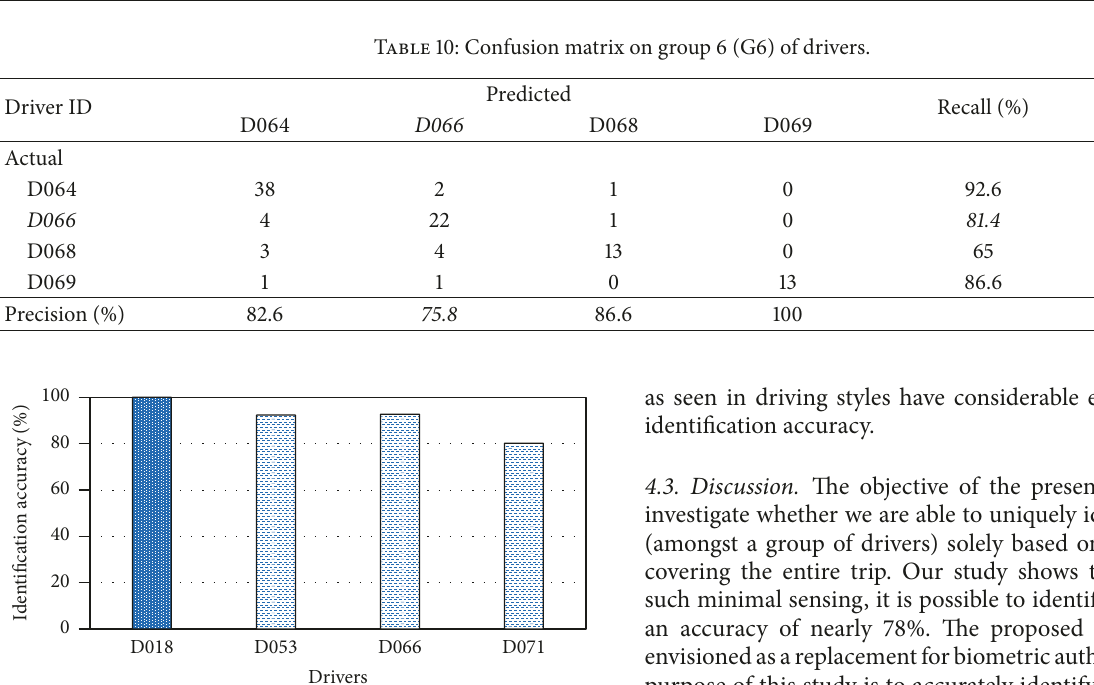
Figure6: Identification accuracy obtained ina group ofdriverswith very high skills.